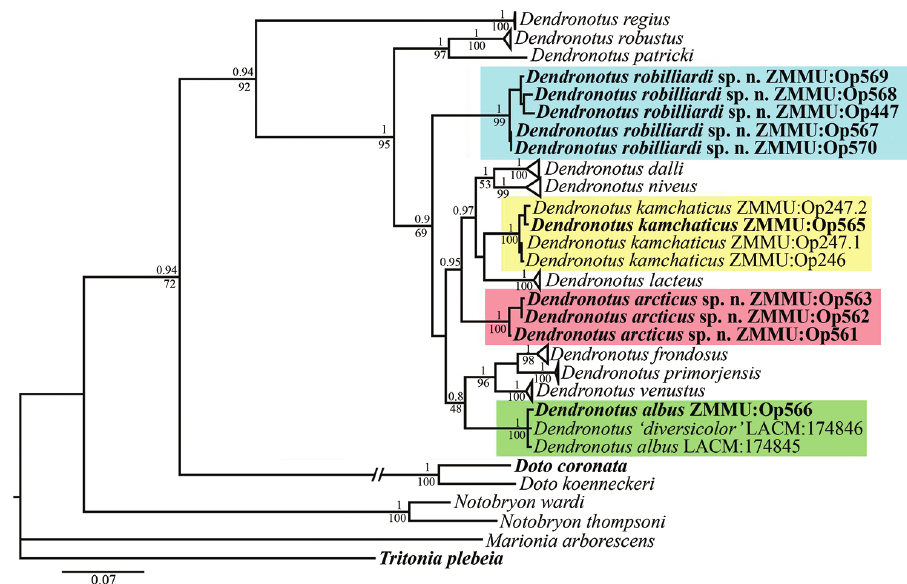
Figure 5. Phylogenetic tree based on combined molecular data (COI + 16S + 28S) represented by Bayes- ian Inference. Numbers above branches represent posterior probabilities from Bayesian Inference. Num- bers below branches indicate bootstrap values for Maximum Likelihood. Some branches are collapsed at species level. New specimens are highlighted in